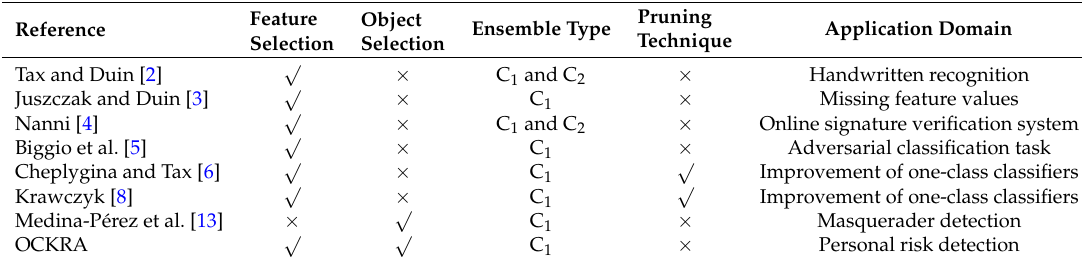
Table 1. Summary and comparison of the related